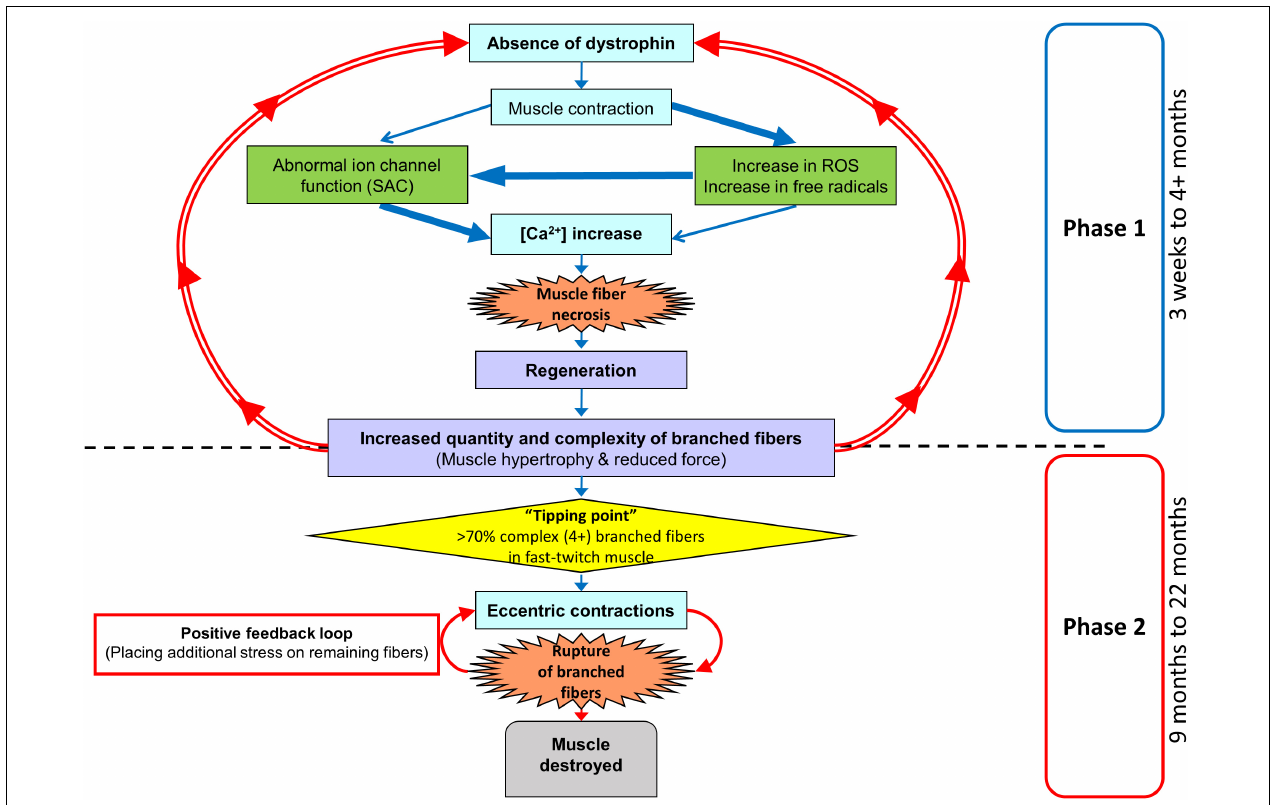
FIGURE 12 | Two-phase model of disease pathogenesis in mdx mice. Phase-one involve the absence of dystrophin triggering skeletal muscle fiber necrosis, driven by a pathological increase in [Ca 2 + ] in . The process is likely caused by a combination of increased free radical damage and abnormal ion channel functioning during muscle contraction. Phase-one involves repeated cycles of muscle fiber regeneration and necrosis leading to the development of abnormally branched regenerated dystrophin-deficient muscle fibers. These branches increase in quantity and complexity with age as the number of repeated regenerative cycles in phase-one increase. Once the number and complexity of the branched fibers passes a level we have termed “tipping point,” phase-two is initiated. Now, the fiber damage is a consequence of the weak branched fibers rupturing, particularly during eccentric contractions. This will tend to have positive feedback as the broken branches will no longer support the contracting muscle placing additional stress on the remaining branches. In the final period of phase-two the majority of muscle tissue will be terminally damaged beyond repair. It is important to note, that depending on the forces experienced by the muscle, phase-one and phase-two can occur at the same